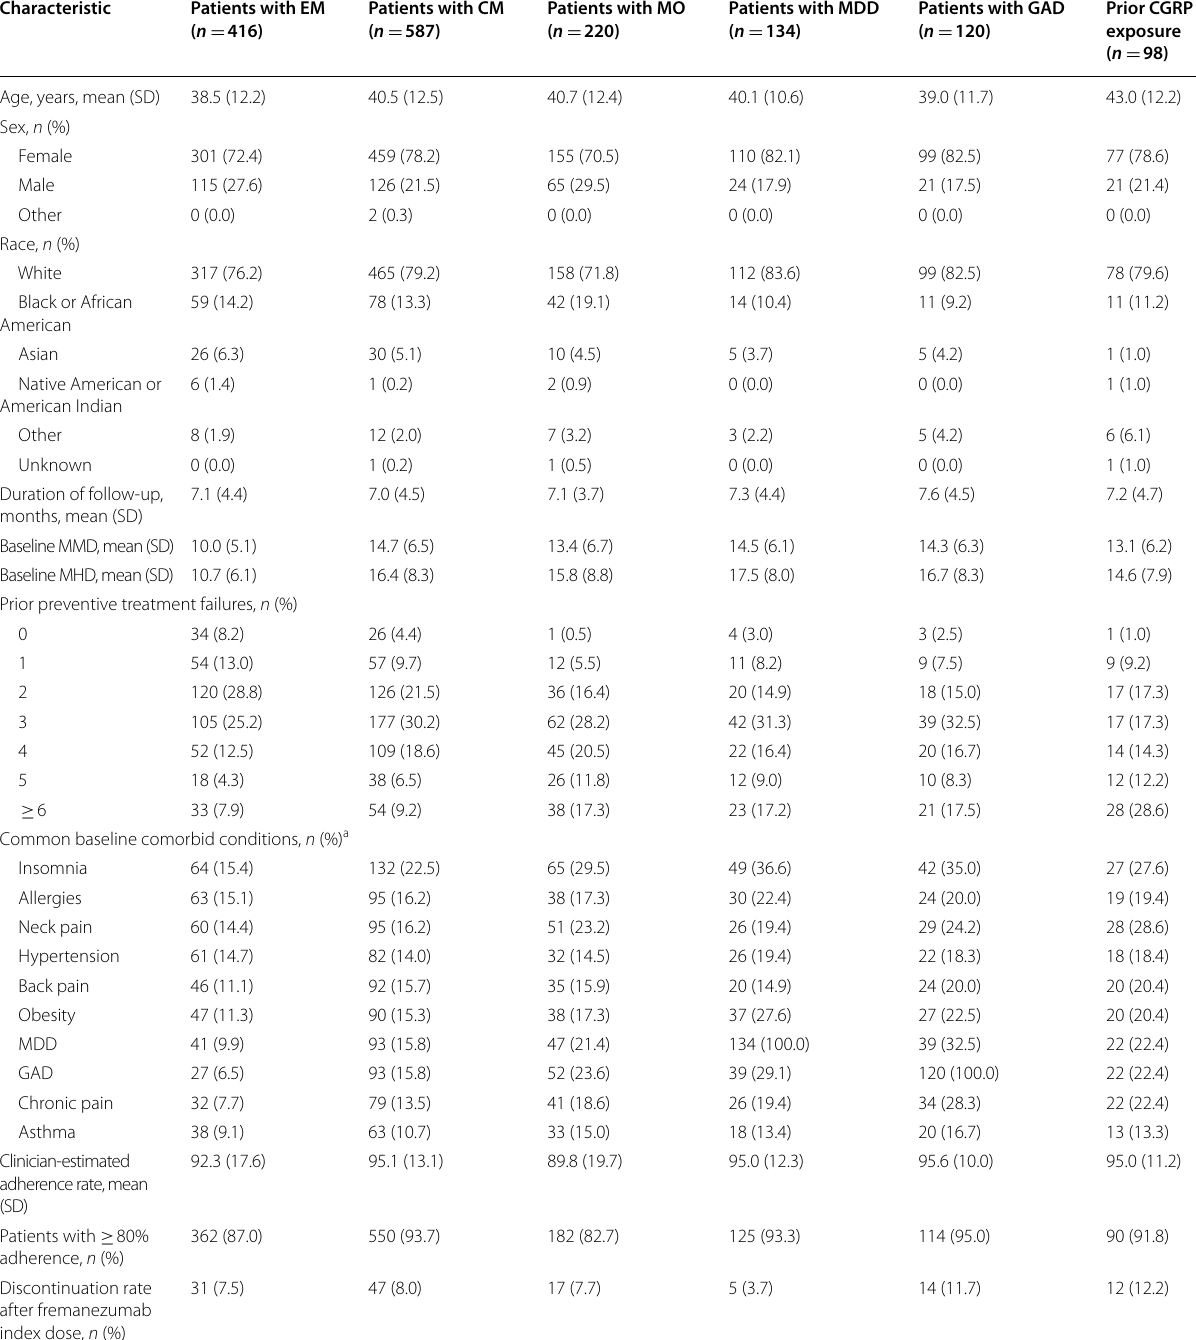
Table 1 Demographic and Baseline Characteristics Across Patient